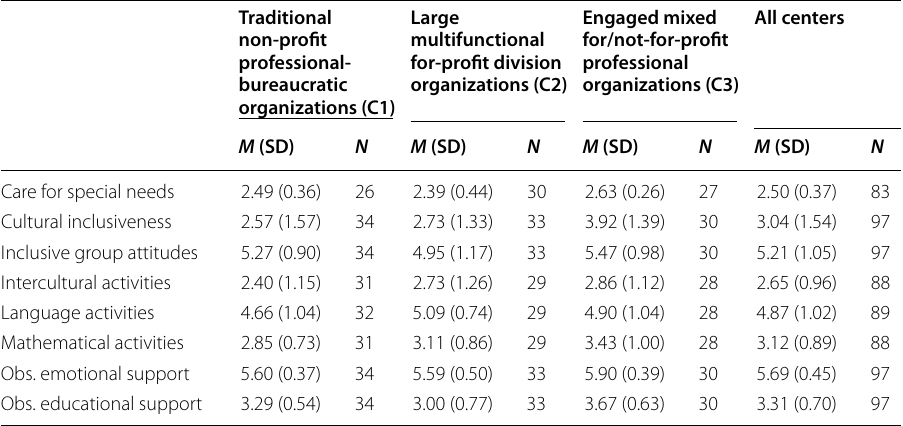
Table 5 Teacher-reported group composition characteristics (partly overlapping) by organizational